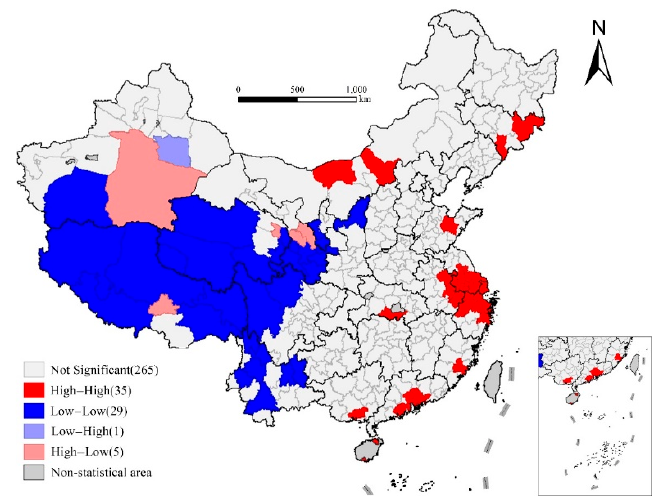
Figure 3. LISA Cluster Map of life expectancy at birth in prefecture-level cities in